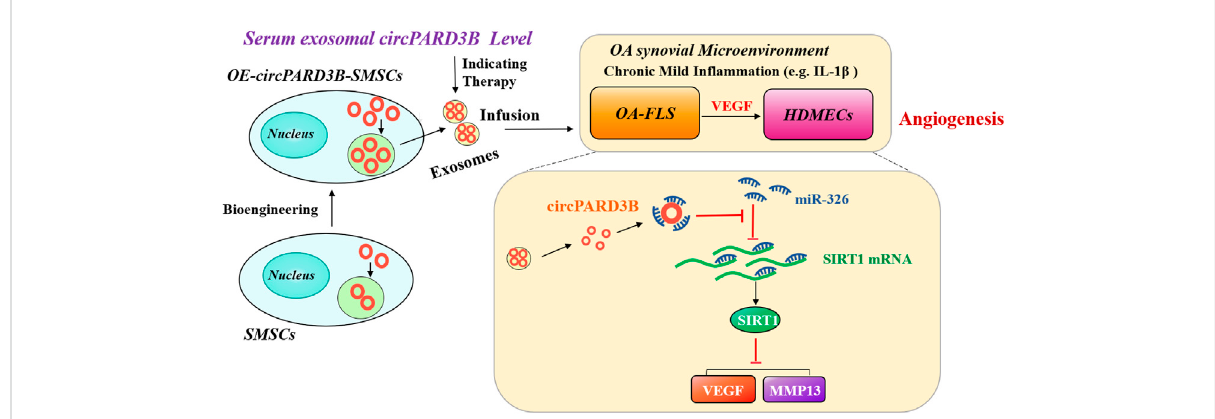
FIGURE 7 The mechanism of OE-circPARD3B-SMSCs-sEV therapy in OA. SMSCs stably overexpressing circPARD3B (OE-circPARD3B-SMSCs) were constructed after infected by the adenovirus. CircPARD3B derived from OE-circPARD3B-SMSCs might play a role as a sponge for the SIRT1- targeting miR-326. The downstream VEGF along with its conducted angiogenesis was then suppressed, with reduced expression of extracellular matrix (ECM) degrading enzyme MMP13 under local in fl ammatory microenvironment, such as IL-1 β , ultimately inhibition of OA disease progression. Therefore, incontrast with thetreatment ofsingle SMSCs-sEV,the intracellular transferof circPARD3B by OE-circPARD3B-SMSCs-sEV showed the better curative effect. Serum sEV circPARD3B level was found to be signi fi cantly downregulated in special phenotype OA patients with evident synovitis, suggesting that serum sEV circPARD3B might serve as a novel biomarker for the in fl ammatory phenotype of OA as well as